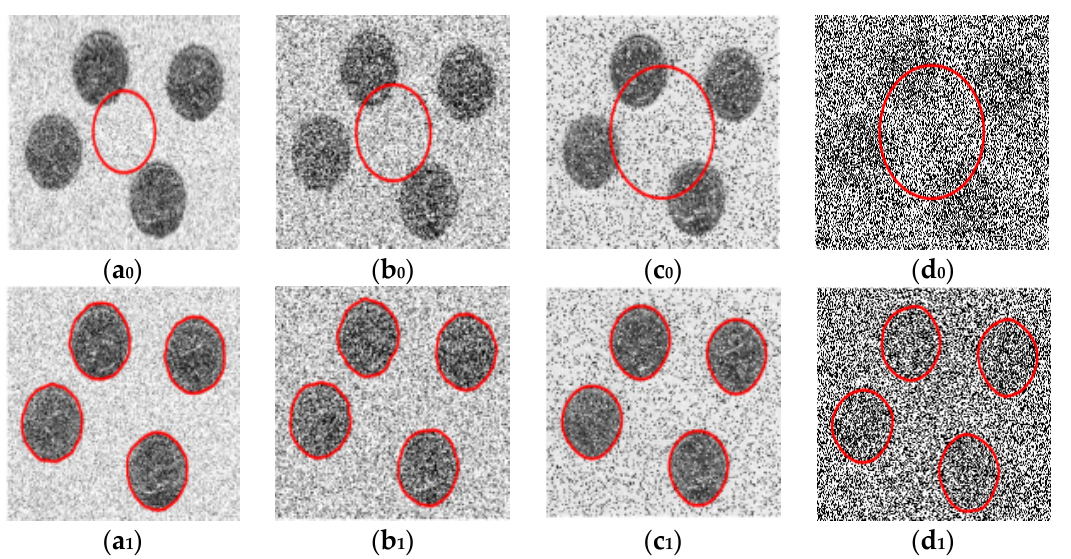
Figure 5. Image segmentation results with different noise levels: ( a 0 –b 0 ) are images with Gaussian noise with a mean of 0 and variances of 0.05 and 0.2, respectively. ( c 0 –d 0 ) are images with pretzel noise with levels of 0.2 and 0.8, respectively. ( a 1 – d 1 ) are the segmentation results corresponding to ( a 0 – d 0 ),